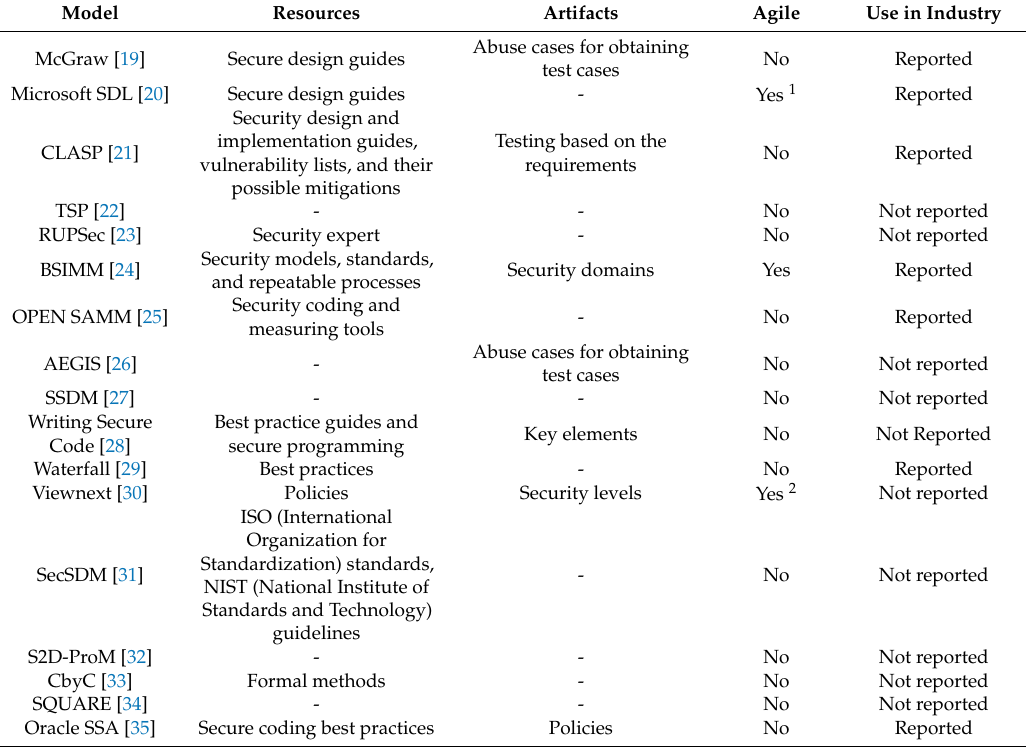
Table 2. Comparative analysis of S-SDLCs at the level of resources, artifacts, agile properties, and use in the software